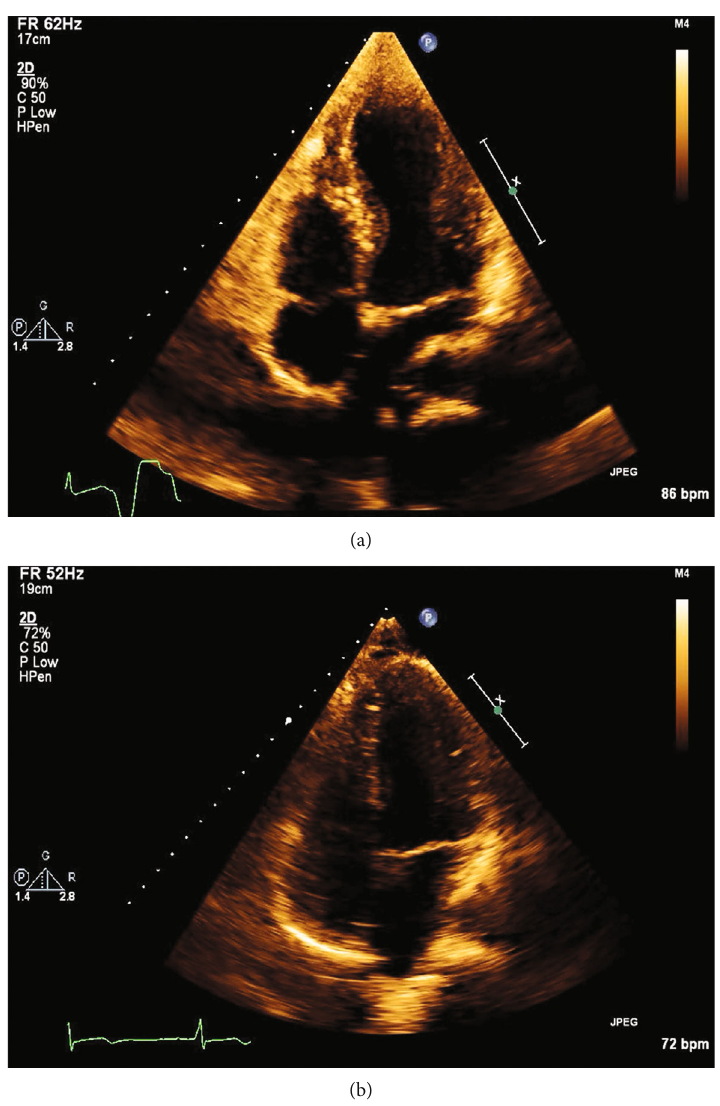
Figure 2: (a) TTE apical 4-chamber view in systole, demonstrating apical ballooning, suggestive of Takotsubo ’ s stress-induced cardiomyopathy. (b) 14 days later: TTE apical 4-chamber view in systole, demonstrating resolution of patient ’ s Takotsubo ’ s stress- induced